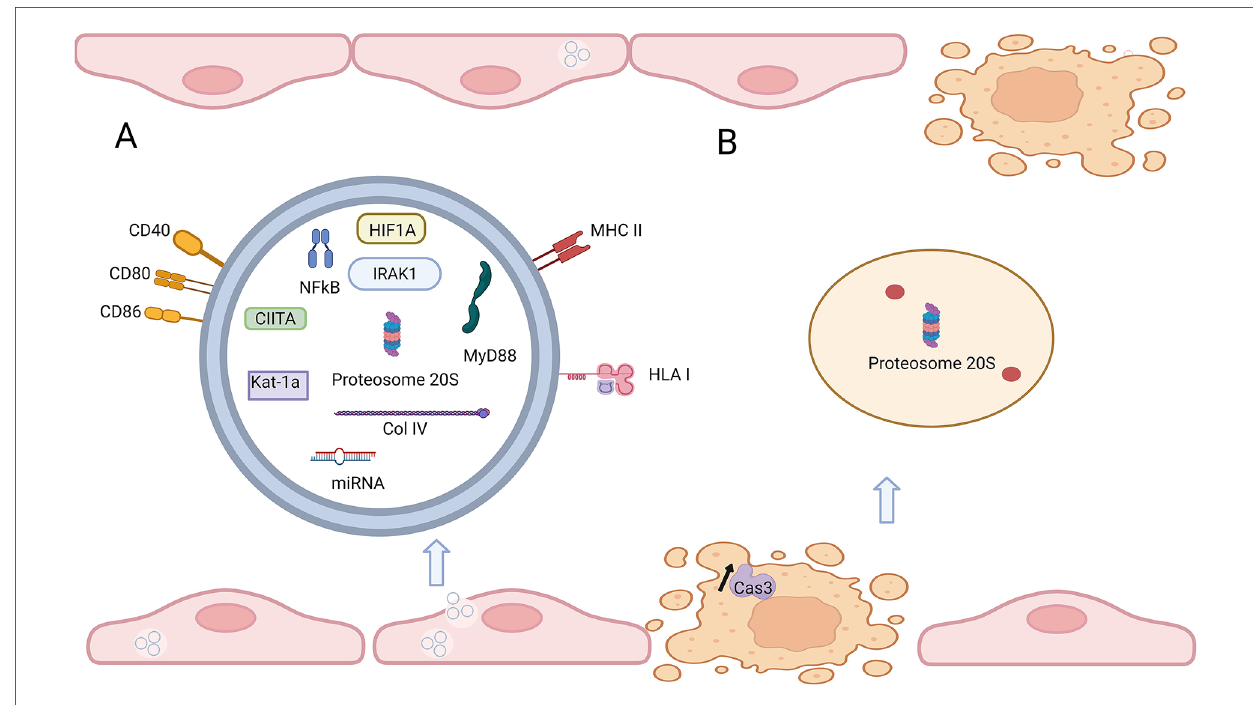
FIGURE 3 Exosome and exosome-like vesicles (ApoExo) released during graft rejection. (A) Molecules present or overexpressed in exosomes from patients undergoing lung transplant rejection, compared to stable transplants. (B) ApoExo released after Caspase 3-dependent death of microvascular endothelial cells. Made in biorender